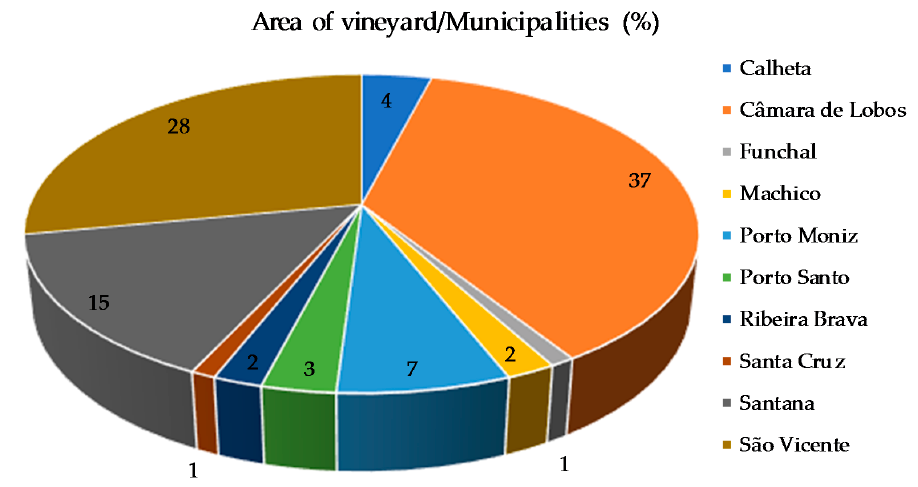
Figure 1. Percentage of vineyard area by municipalities of Madeira Island [3].